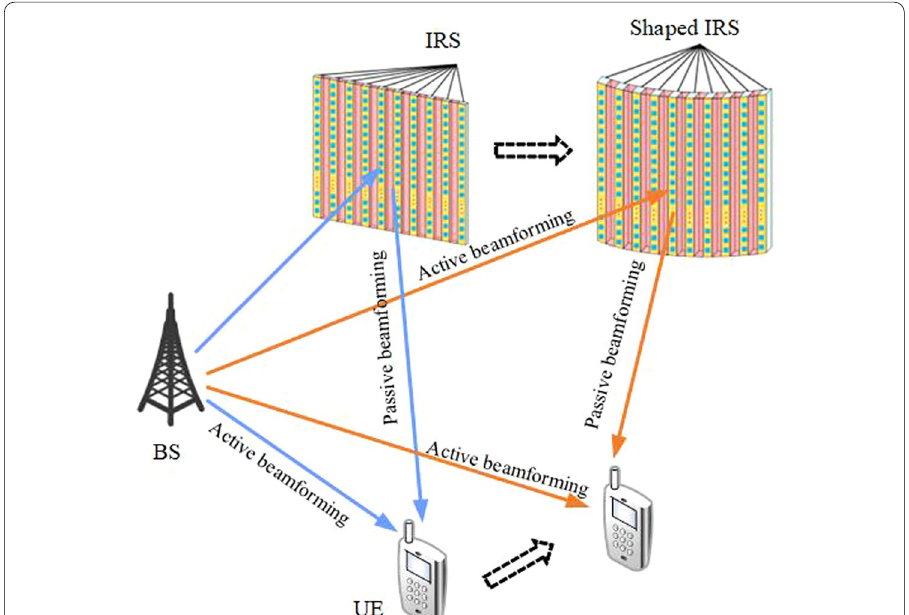
Fig. 5 Deformable IRS that meets application requirements. The shape-adaptive IRS can flexibly change the shape through mechanical control, thereby alleviating the requirements for IRS controller and manual unit